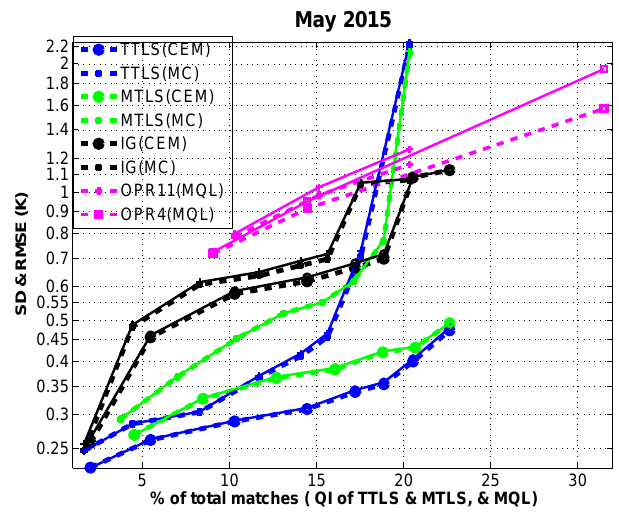
Figure 4. Comparative retrieval results for TTLS, MTLS, OPR11 and OPR4 under two different cloud detection schemes (MC and CEM); MQL stands for MODIS cloud with MODIS QL, and MC stands for MODIS cloud with TTLS